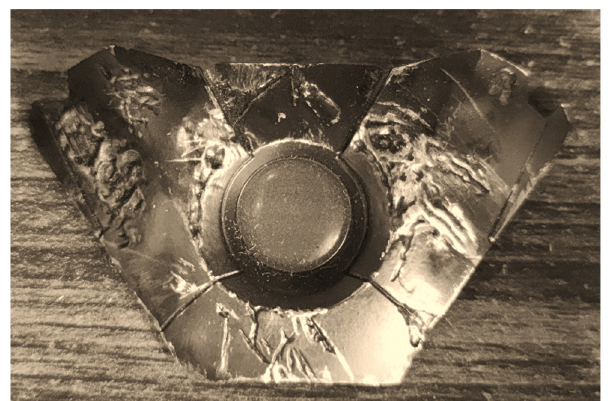
Figure 5. Actual Battle Damage Distribution of Armor.